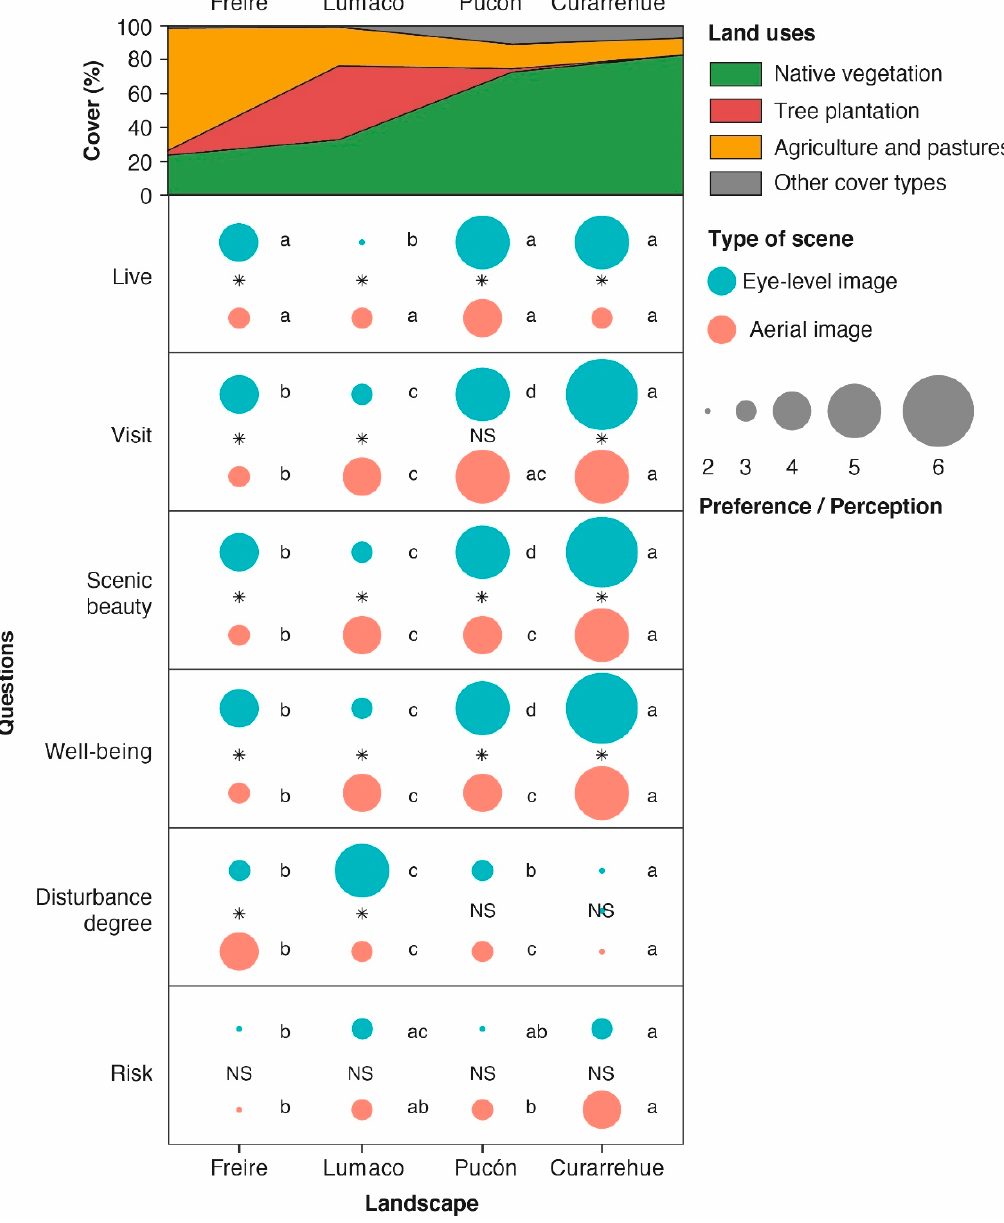
Figure 4. Mean score (Likert scale) of landscape preferences and perceptions using eye-level and aerial images for four landscapes of the La Araucanía Region, south-central Chile. n.s: not significant; * p < 0.01 for individual comparisons for each landscape in each question. For the exact values of the lower panel of the figure, see Appendix D. Different letters show significant differences ( p < 0.05) in Tukey’s post-hoc comparisons in the interaction term of two-way ANOVAs for six questions on preference values for four landscapes using two image types (eye-level and aerial).